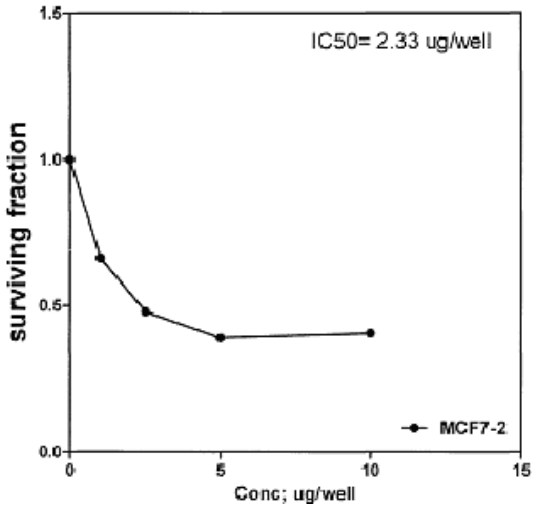
Figure 5. Effect of conc. of 17 on MCF-7 line.